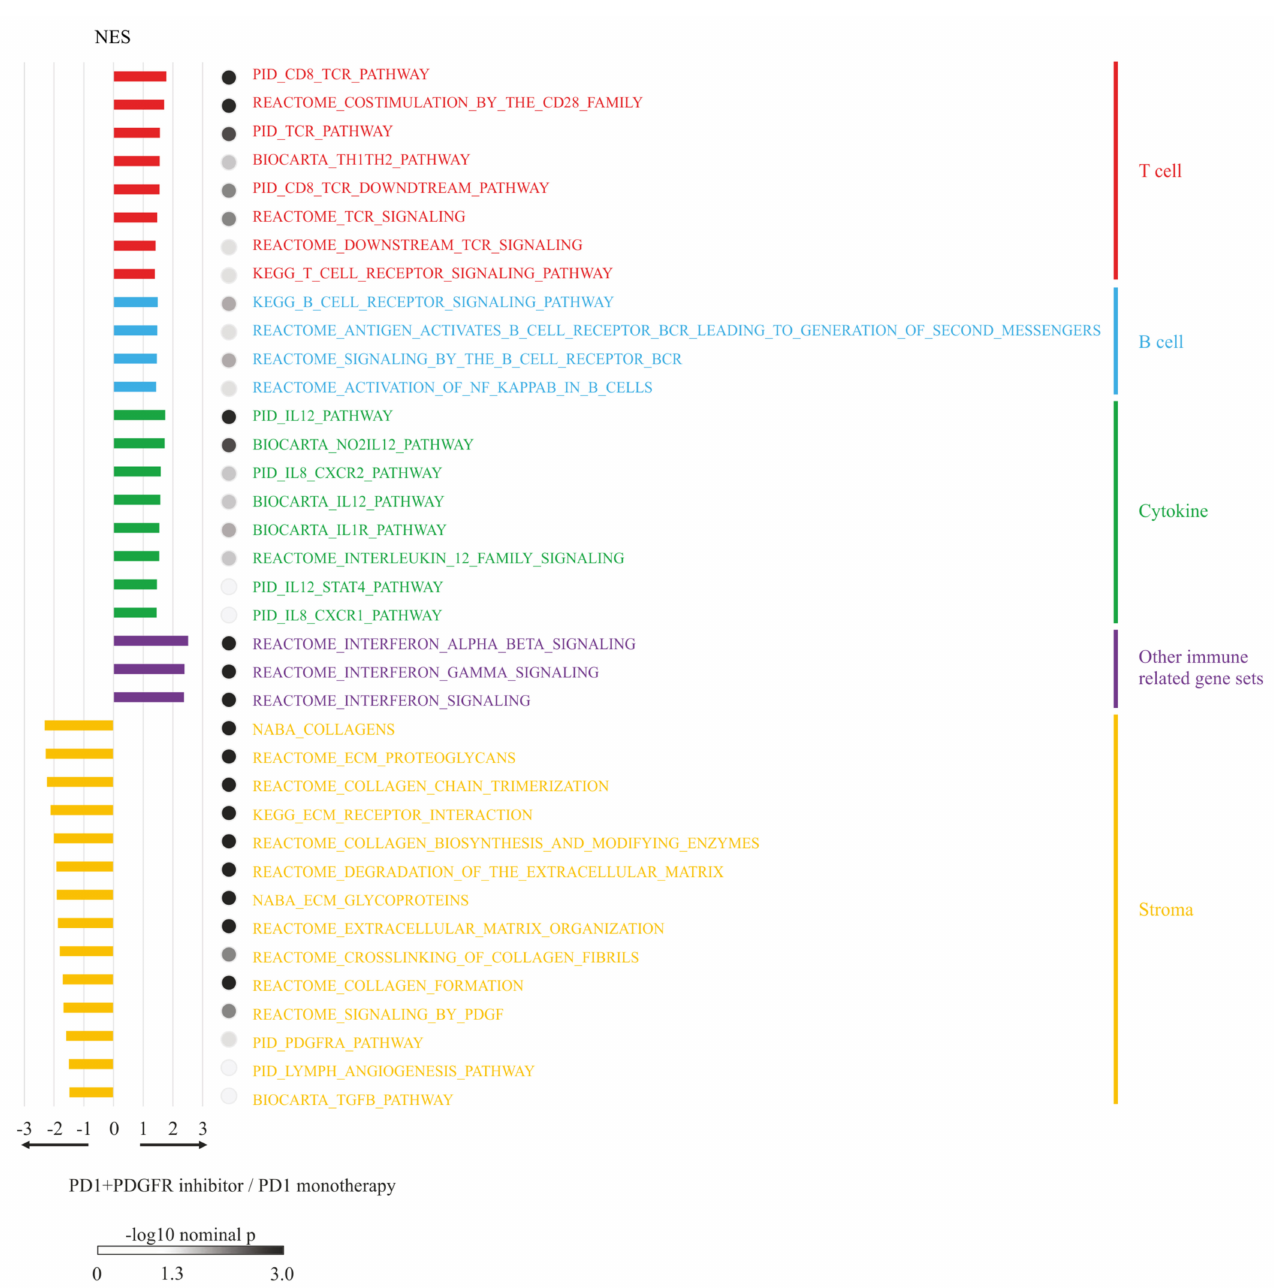
Figure 4. Gene set enrichment analysis (GSEA). RNA-seq was performed to compare the excluded- type liver-metastasis tumors treated with anti-PD-1 antibody monotherapy with those treated with a combination therapy of anti-PD-1 antibody plus dasatinib. Genes are grouped and color-coded according to their major functions. NES, normalized enrichment score. Complete GSEA report data for anti-PD-1 antibody monotherapy and anti-PD-1 antibody plus dasatinib combination therapy are provided in Supplementary Data S1 (Data S1) and Supplementary Data S2 (Data